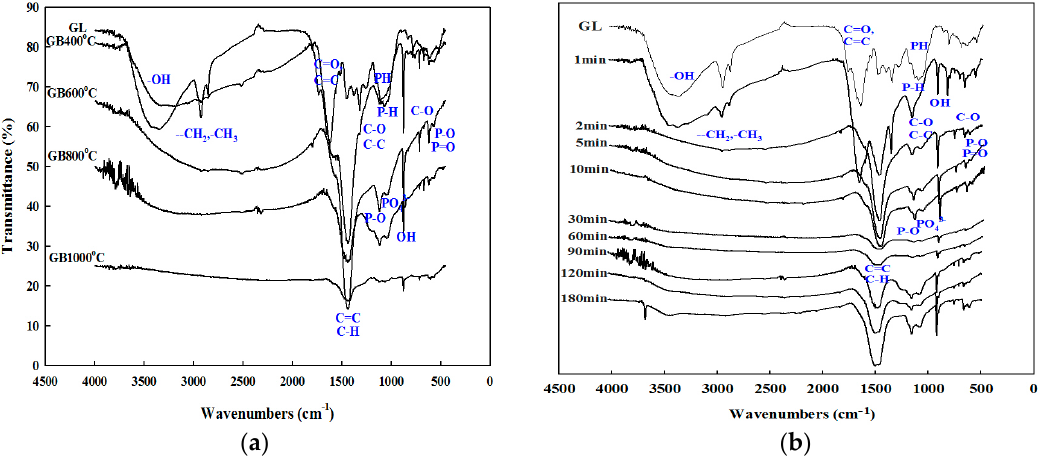
Figure 1. Fourier ‐ transform ‐ infrared (FTIR) spectra of the ginkgo leaf (GL) and the ginkgo leaf ‐ derived biochars (GBs) that were produced under different carbonization temperatures ( a ) and times ( b ).